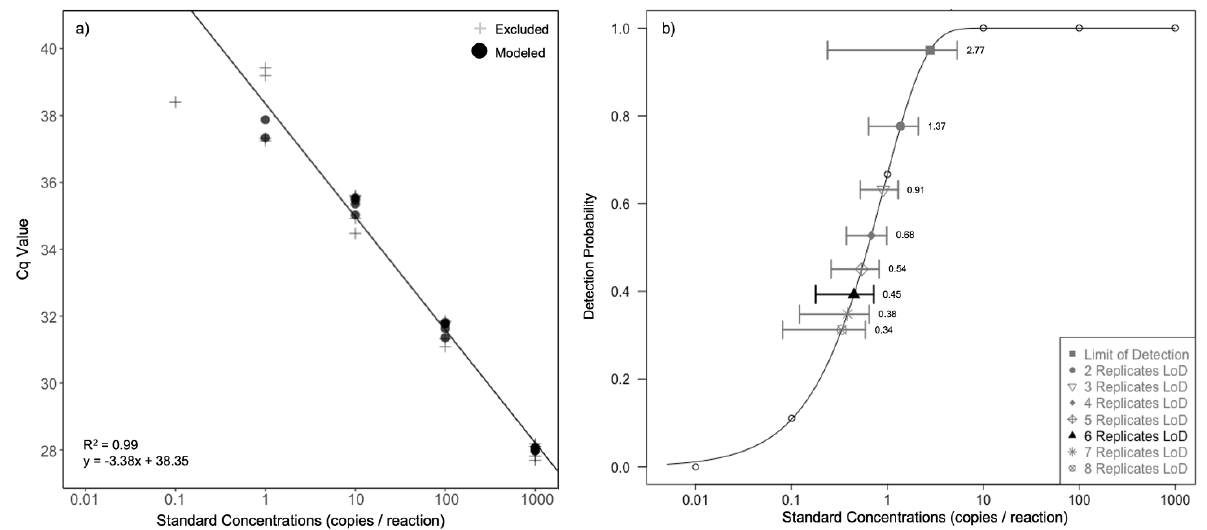
Figure 4. Chironex fleckeri assay sensitivity. ( a ) Standard curve plot from a six point ten-fold serial dilution of synthetic DNA, from theoretical 1000 to 0.01 copies µ L − 1 . Grey pluses (+) are replicates which fall outside the middle two quartiles for standards or are standards with less than 50% detection, both of which were excluded from linear regression calculations. ( b ) Effective Limit of Detection (LoD) for each quantity of technical replicates as determined via a Weibull type II two parameter function which has an upper limit of one. Effective LoDs are plotted with 95% confidence intervals ( n = 8) and open circles represent the detection rates of each standard.